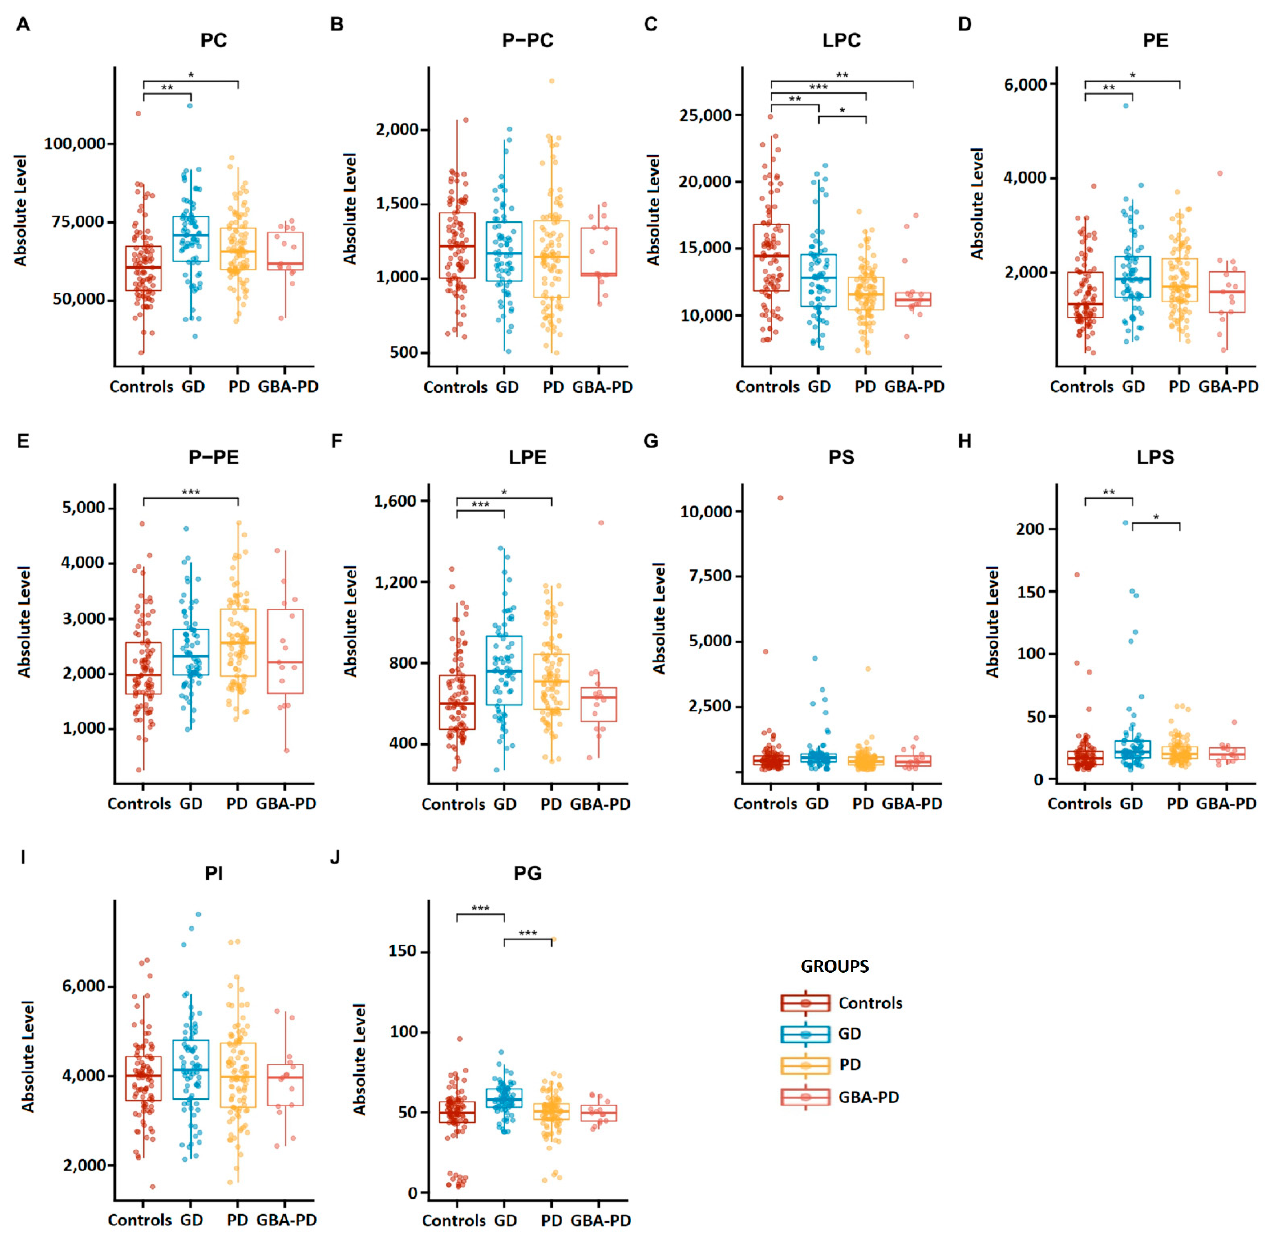
Figure 1. Absolute phospholipid levels plotted by group ( A – J ). PD Parkinson’s disease, GBA-PD GBA1 mutation carrier Parkinson’s, GD Gaucher disease, lipid nomenclature as in the text. Lipid data are expressed as normalized intensities relative to exactly measured internal standards and